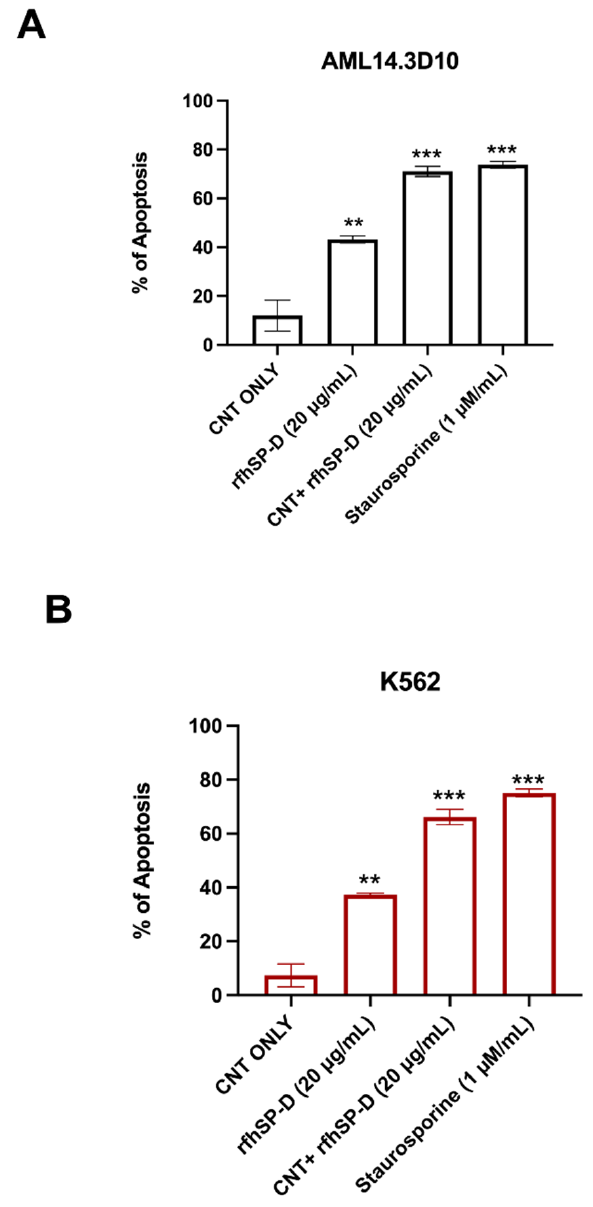
Figure 5. Flow cytometry analysis of apoptosis induction in AML14.3D10 ( A ) or K562 ( B ) cell lines treated with CNT + rfhSP-D. For Annexin V/FITC and DNA/PI staining, 12,000 cells were acquired and plotted. Values are means ± SEM ( n = 3). ** p < 0.01 and *** p < 0.001 compared to CNT only group. The raw data are available in the Supplementary material.